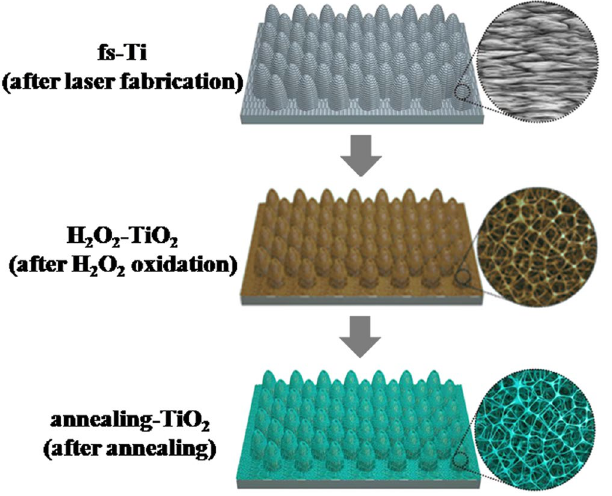
Figure 1. Schematic of the fabrication of anatase TiO 2 micro-nanostructures on Ti substrate by the laser- chemical-hybrid method (Grey: fs-Ti, Brown: H 2 O 2 -TiO 2 , Green: annealing-TiO 2 ).